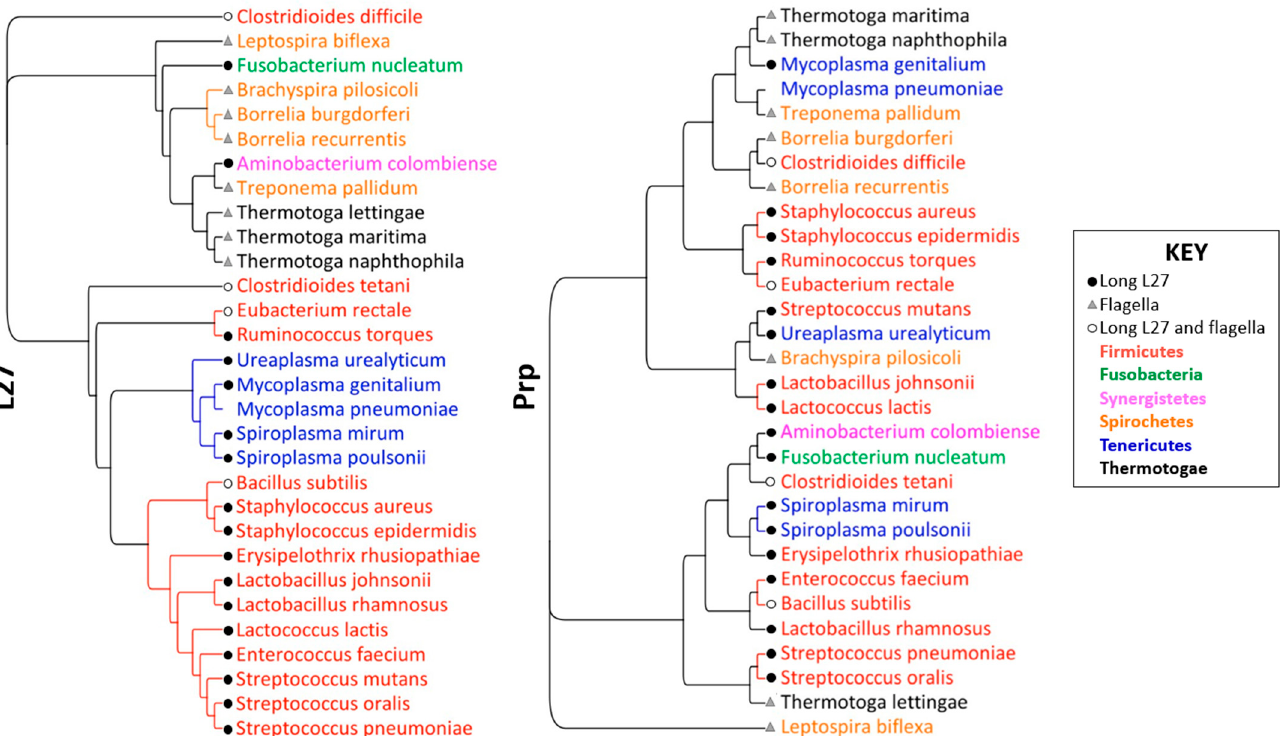
Figure 2. Phylogenic trees of select species of Prp-encoding phyla. (Left): L27 sequence comparison. (Right): Prp sequence comparison. Image created with Geneious version 2022.1 Biomatters.